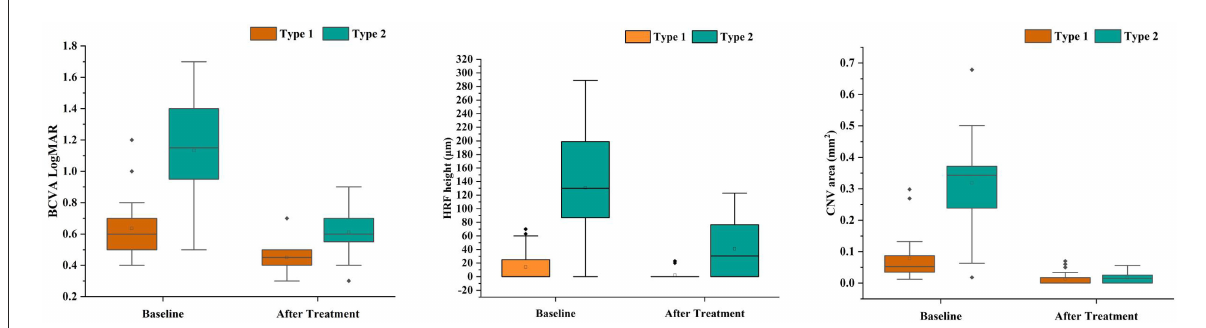
FIGURE3 Box plots showed the results before and after anti-VEGF treatment in patients with pathologic myopia choroidal neovascularization (PM-CNV). Each box shows median (central horizontal line), mean (cross inside the box), and interquartile range (horizontal extremes of the box) values for each variable. The ends of the whiskers represent the minimum and maximum values. Dots not included in whiskers represent outliers. Each graph shows values of a different metric in each of the two groups. P values for each comparison are reported. Details on pairwise comparisons are presented in Table 3.